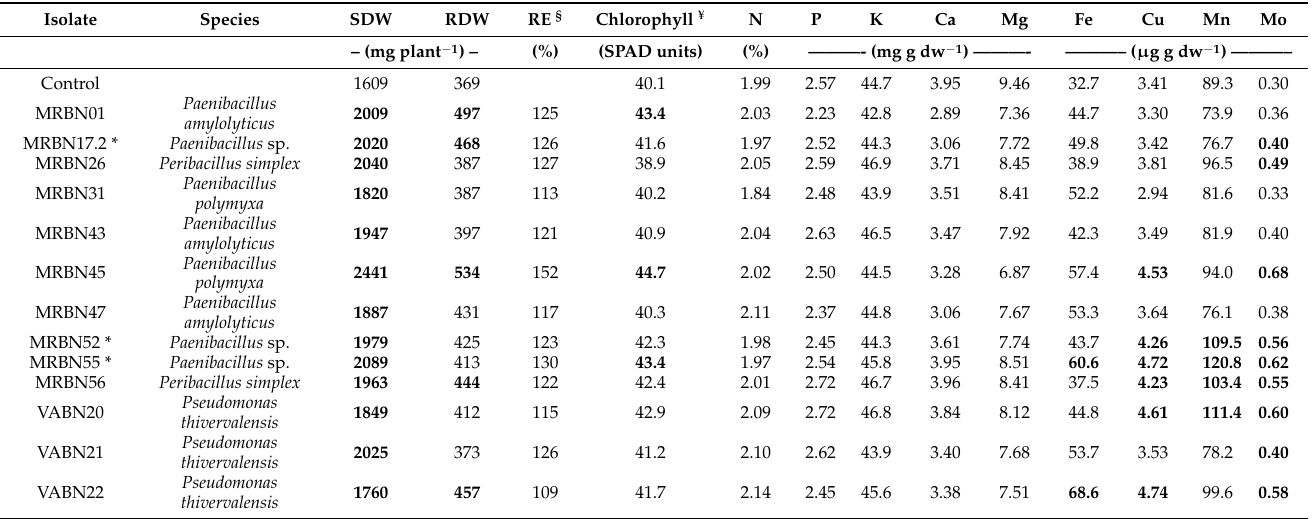
Table 3. Growth parameters and shoot mineral content of canola plants grown in an agricultural soil under greenhouse conditions and inoculated with root endophytic bacterial isolates selected as the best canola growth promoters under hydroponic